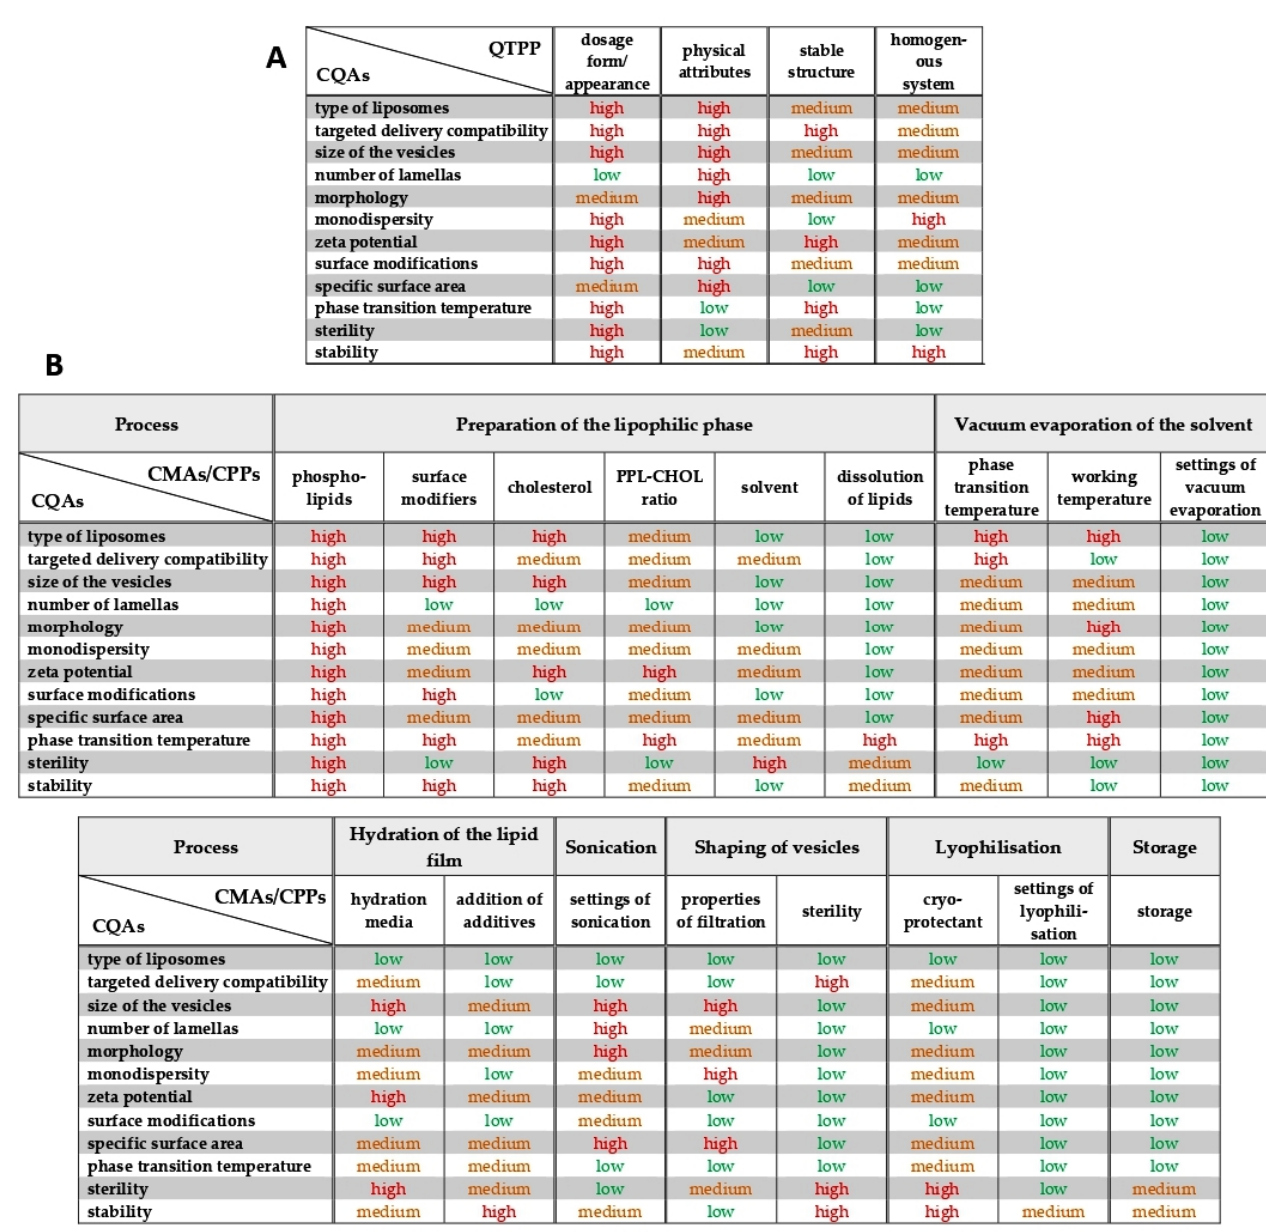
Figure 1. Results of the interdependence investigations between the elements of the Quality Target Product Profile (QTPP) and the Critical Quality Attributes (CQAs) ( A ), and between the CQAs and the Critical Material Attributes (CMAs) and the Critical Process Parameters (CPPs) ( B ).